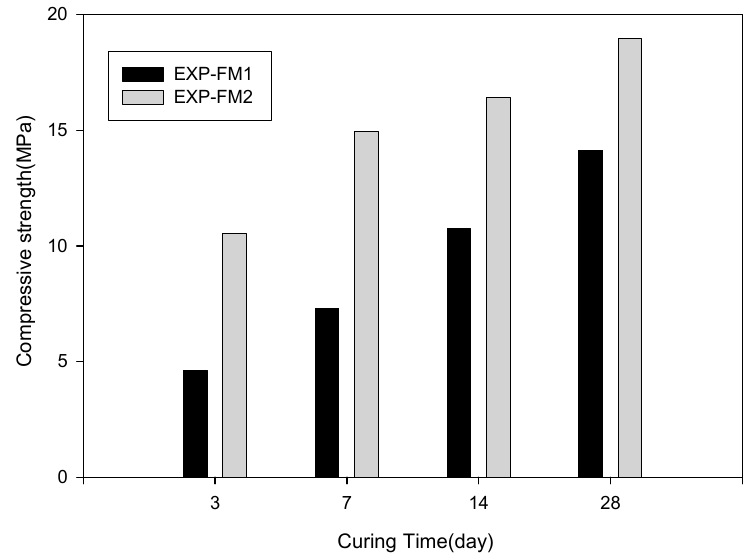
Figure 10. Compressive strength for different mixing ratios and curing times.